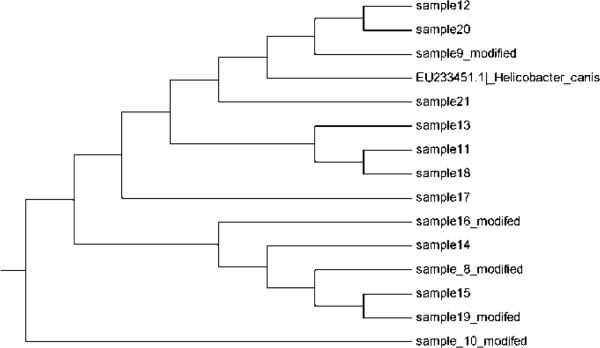
Helicobacteraceae DNA was detected with single PCR in all the colonic biopsies: Evolutionary relationships of taxa for
helicobacter canis
the evolutionary history was inferred using the UPGMA, Kimura 2-parameter and MEGA5 methods.